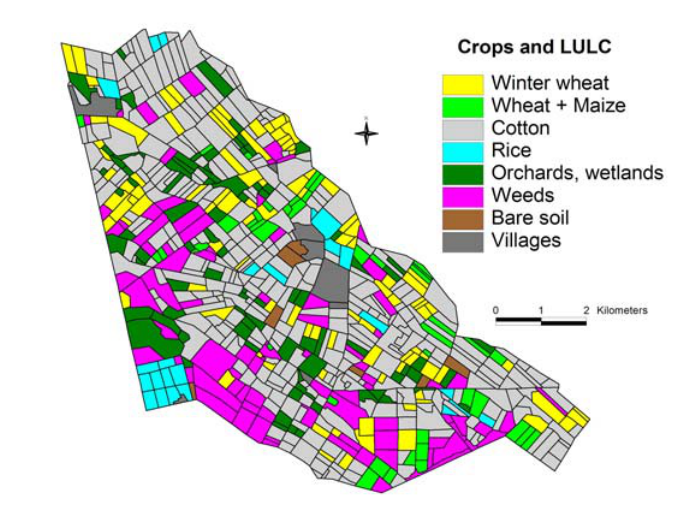
Figure 3. Crop types inside the Galaba farm, derived using time-series Landsat ETM+ images for year